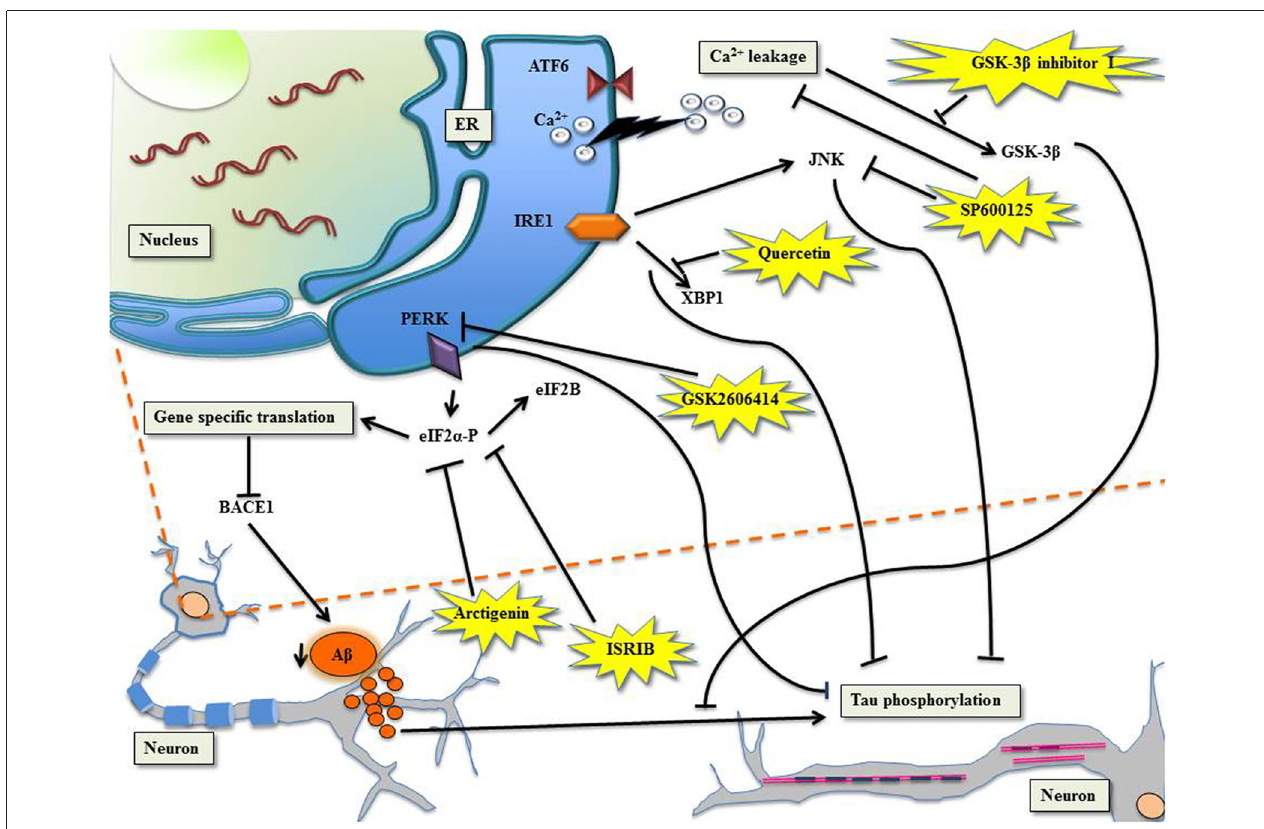
FIGURE 1 | Targeting unfolded protein response (UPR) to manage Alzheimer’s disease (AD) with specific molecules. PERK/eIF2 α : the phosphorylation of eIF2 α shuts down global translation in the cell but for gene-specific translation upregulation of mRNA with internal ribosome entry site (IRES), for example β -site APP cleaving enzyme-1 (BACE1), the β -secretase enzyme (Ohno, 2014). Arctigenin, targets eIF2 α -P thereby downregulating BACE1, consequently protects neurons from amyloid- β (A β ) toxicity. ISRIB, affects eIF2B leading to inhibition of eIF2 α -P, which comprehensively restores protein translation and hence enhances long term memory. PERK can be directly inhibited by GSK2606414, leading to halt in tau phosphorylation. Ca 2 + leakage induced activation of glycogen synthase kinase-3 β (GSK-3 β ) can be checked by GSK-3 β inhibitor I, which prevents A β induced phosphorylation of tau. IRE1/XBP1 : Quercetin, activates endoribonuclease activity